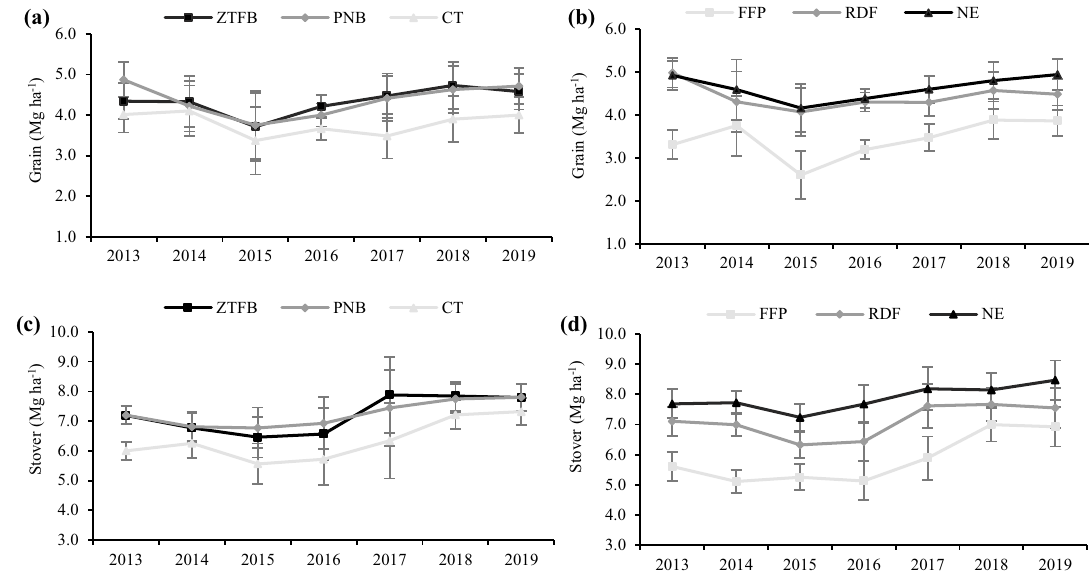
Figure 1. Seven years’ grain ( a , b ) and stover ( c , d ) yields trend of the maize under the CA-based CEP and nutrient management in the maize–chickpea rotation. The vertical bars indicate the LSD at p = 0.05. Maize Treatment